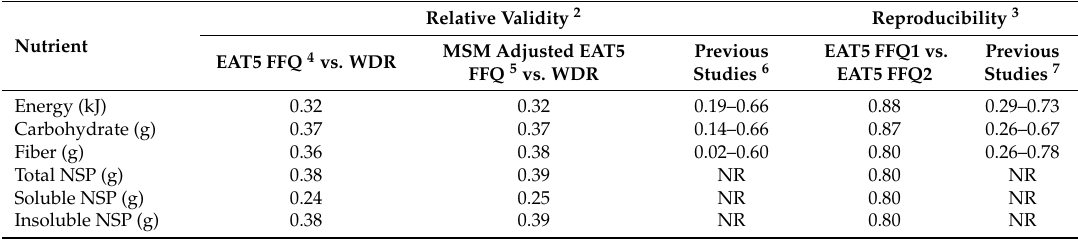
Table 2. Nutrient correlations between the EAT5 FFQ and WDR ( n = 100), and reproducibility correlations ( n = 99) in 5-year old children 1